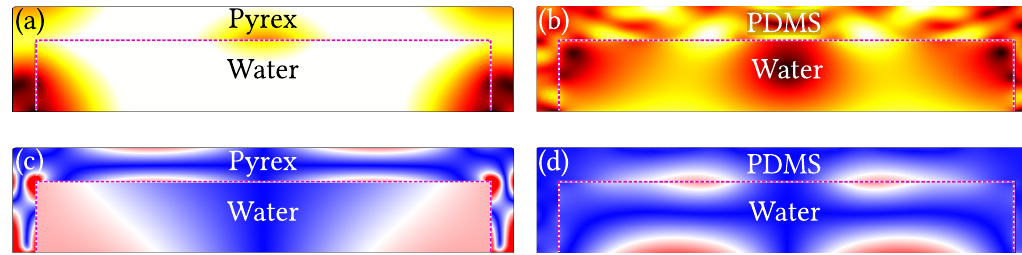
Figure 2. Examples of full model results for h = 125µm, w = 600µm, and H = 60µm (see Figure 1b). ( a ) Color plot from 0 mm/s ( black ) to 2.0 mm/s ( white ) of the velocity field (cid:12) (cid:12) (cid:12) v f (cid:12) in the water obtained in a full-model simulation of a pyrex SAW device actuated at the on-resonance frequency f res = 1.24 MHz; ( b ) The same as in ( a ) but for a full-model PDMS SAW device. The dashed magenta line indicates the solid-fluid interface; ( c ) Color plot from 0 ( dark blue ) to 8 × 10 − 7 ( dark red ) of the amplitude of the the relative volume change | ∇ · u s | in the Pyrex and the rescaled pressure (cid:12) (cid:12) (cid:0) 1 (cid:1) K pyrex in the fluid, of the full model from ( a ), where K pyrex is the bulk modulus of Pyrex; (cid:12) p f (cid:12) / 5 ( d ) The same as ( c ) but for the full model from ( b ) and the rescaled pressure modulus K PDMS of